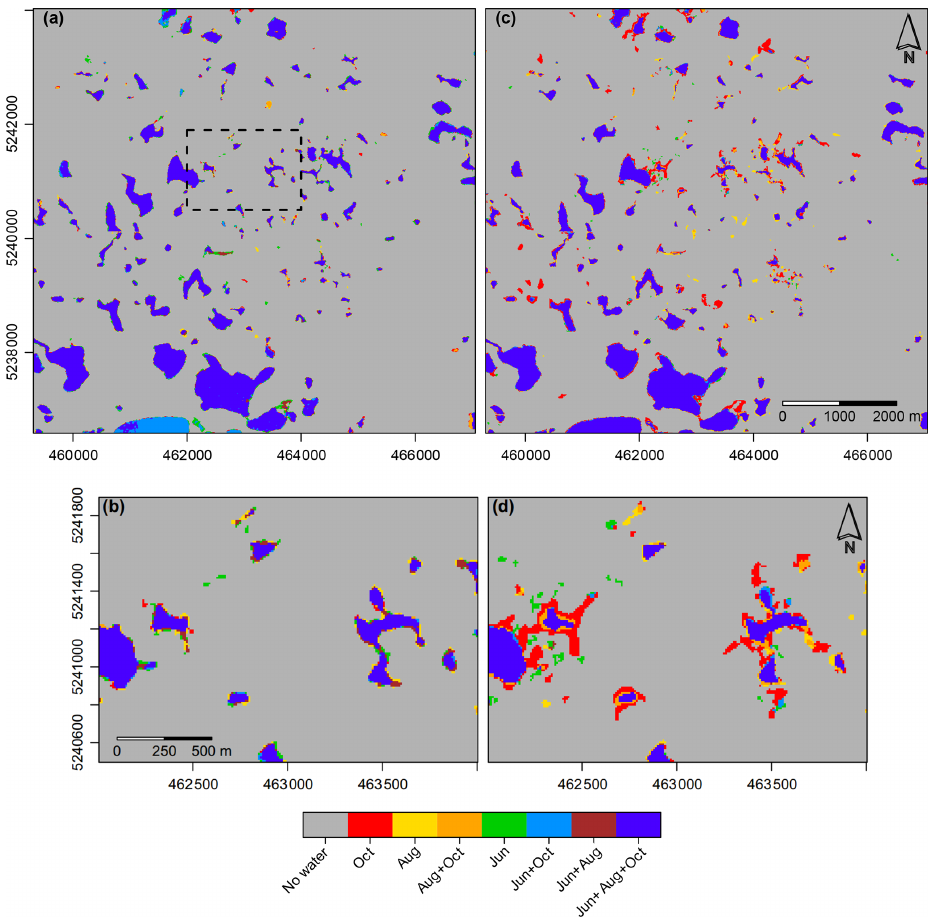
Figure 10. Water extent dynamics in (a, b) 2016 and (c, d) 2019 in a subset of the study area. Observation times refer to 5 July 2016 and 14 June 2019, 10 August 2016 and 13 August 2019, and 27 October 2016 and 24 October 2019 respectively. The “ + ” symbol denotes water detected at multiple observation times. Dark blue areas were detected as water on all three dates. The box in panel (a) marks the extent of the detailed maps shown in panels (b) and (d) . Scales show coordinates in the Universal Transverse Mercator system (UTM zone